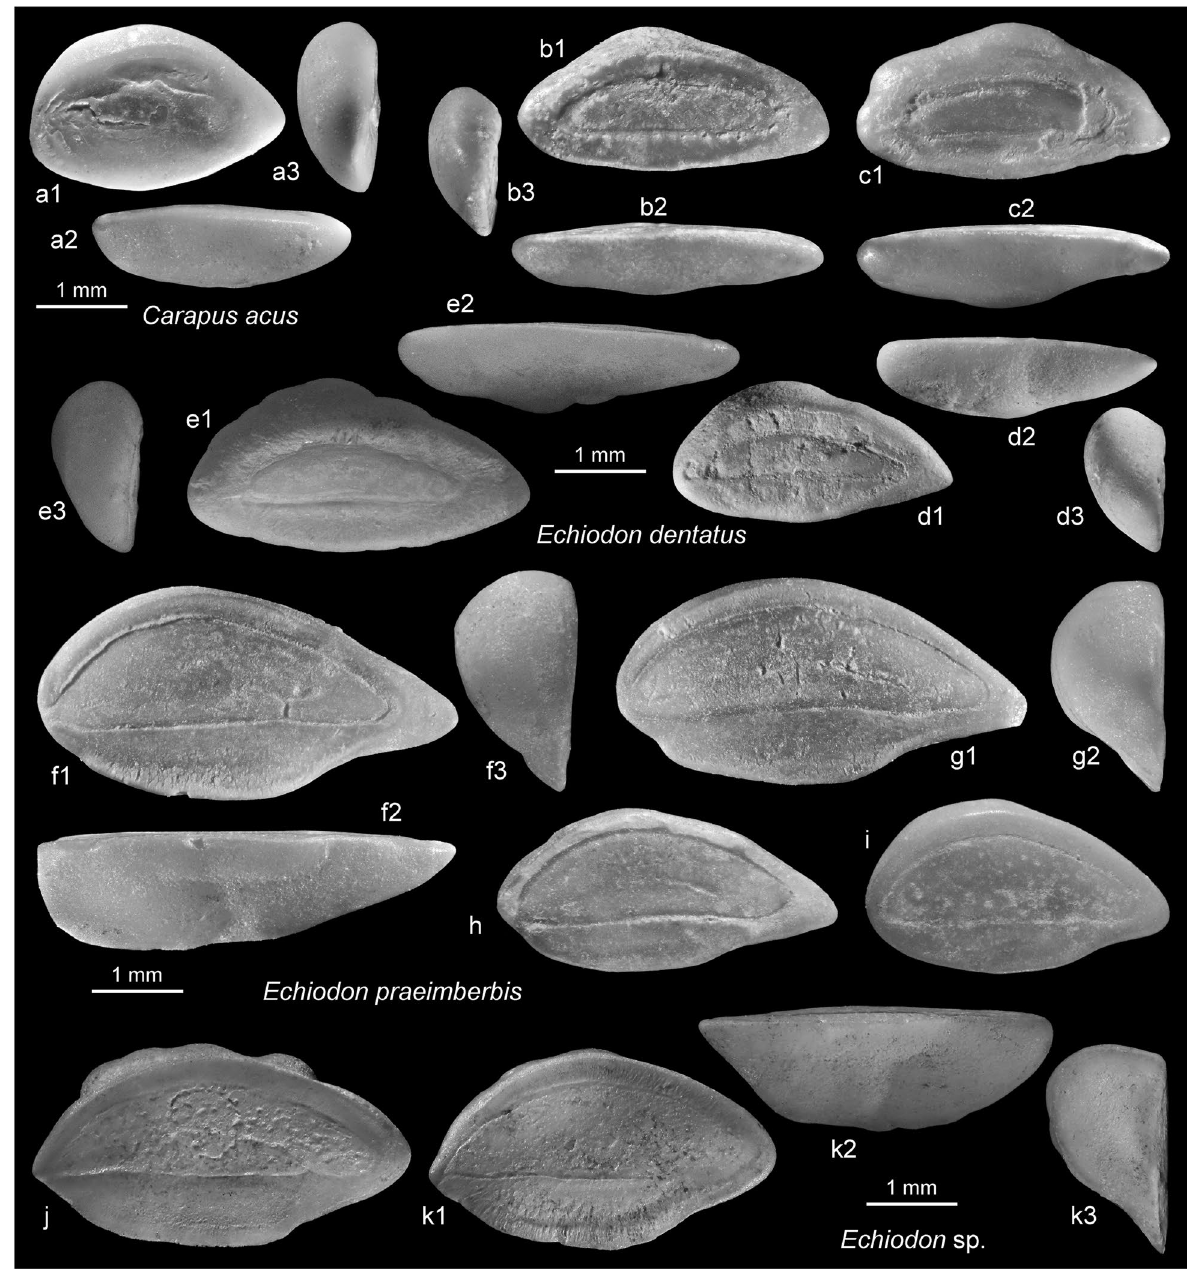
Fig. 15 Ophidiiformes. a Carapus acus (Brünnich, 1768), SMF PO 101.211, Dar bel Hamri. b – d , Echiodon dentatus (Cuvier, 1829), b , c SMF PO